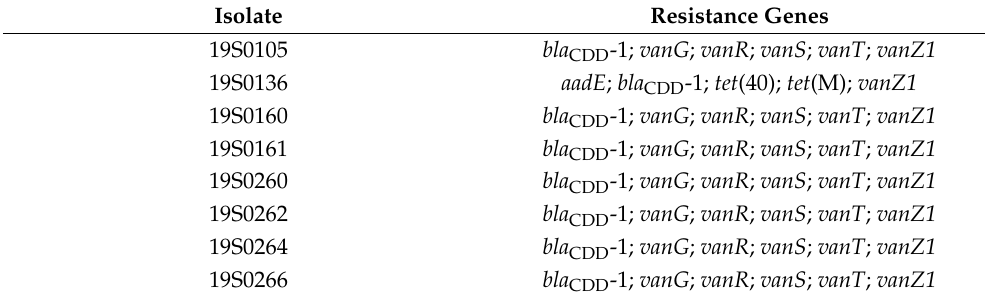
Table 3. Resistance genes identified in the C. difficile isolates from SAC.